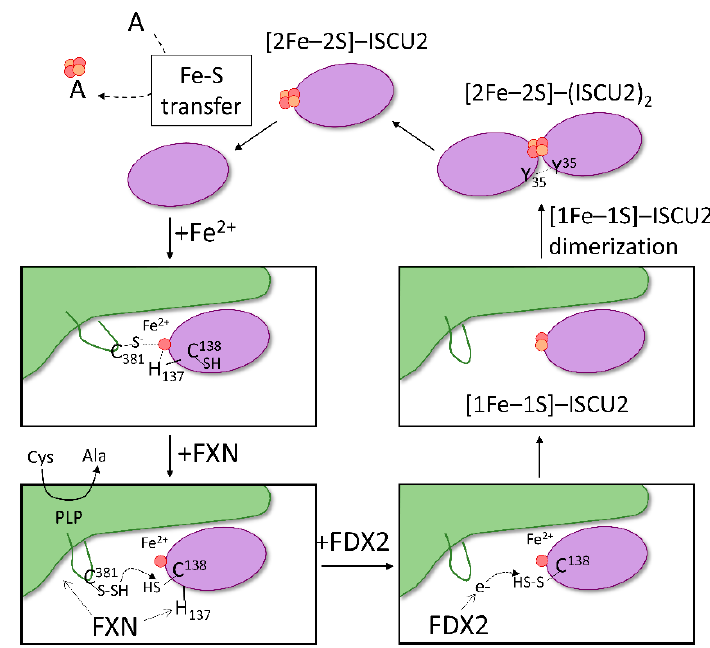
Figure 6. Proposed model of Fe–S assembly in the Fe–S core complex. The proposed mechanism begins with binding of iron to ISCU2 (purple) and the association of Fe 2+ –ISCU2 to NFS1 (green). In the formed SDAU complex, coordination of Fe 2+ site potentially includes the catalytic Cys381 of NFS1 and His137 of ISCU2. Interaction of FXN to both NFS1 and ISCU2 modifies the Fe 2+ environment by shifting ISCU2 His137 away from Fe 2+ , allowing Cys138 to ligate instead. NFS1 Cys381 is free to perform the catalytic generation of persulfide from free cysteine and to transfer it to ISCU2 Cys138. Reduced FDX2 then binds and donates electron to reduce the ISCU2 persulfide. Once sulfur is reduced to sulfide, a [1Fe–1S] precursor is formed on ISCU2. Dimerization of ISCU2, mediated by Tyr35 residues, brings two precursor molecules together to form a [2Fe–2S] cluster on ISCU2. The generated [2Fe–2S] is then available for downstream transfer to acceptors